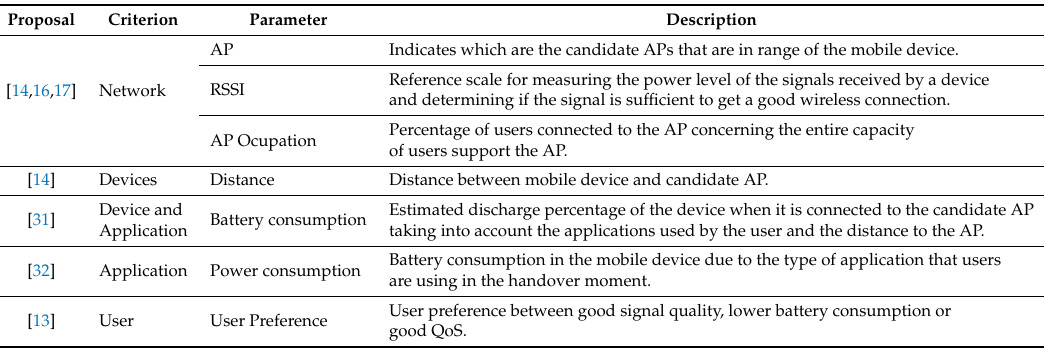
Table 3. Parameter